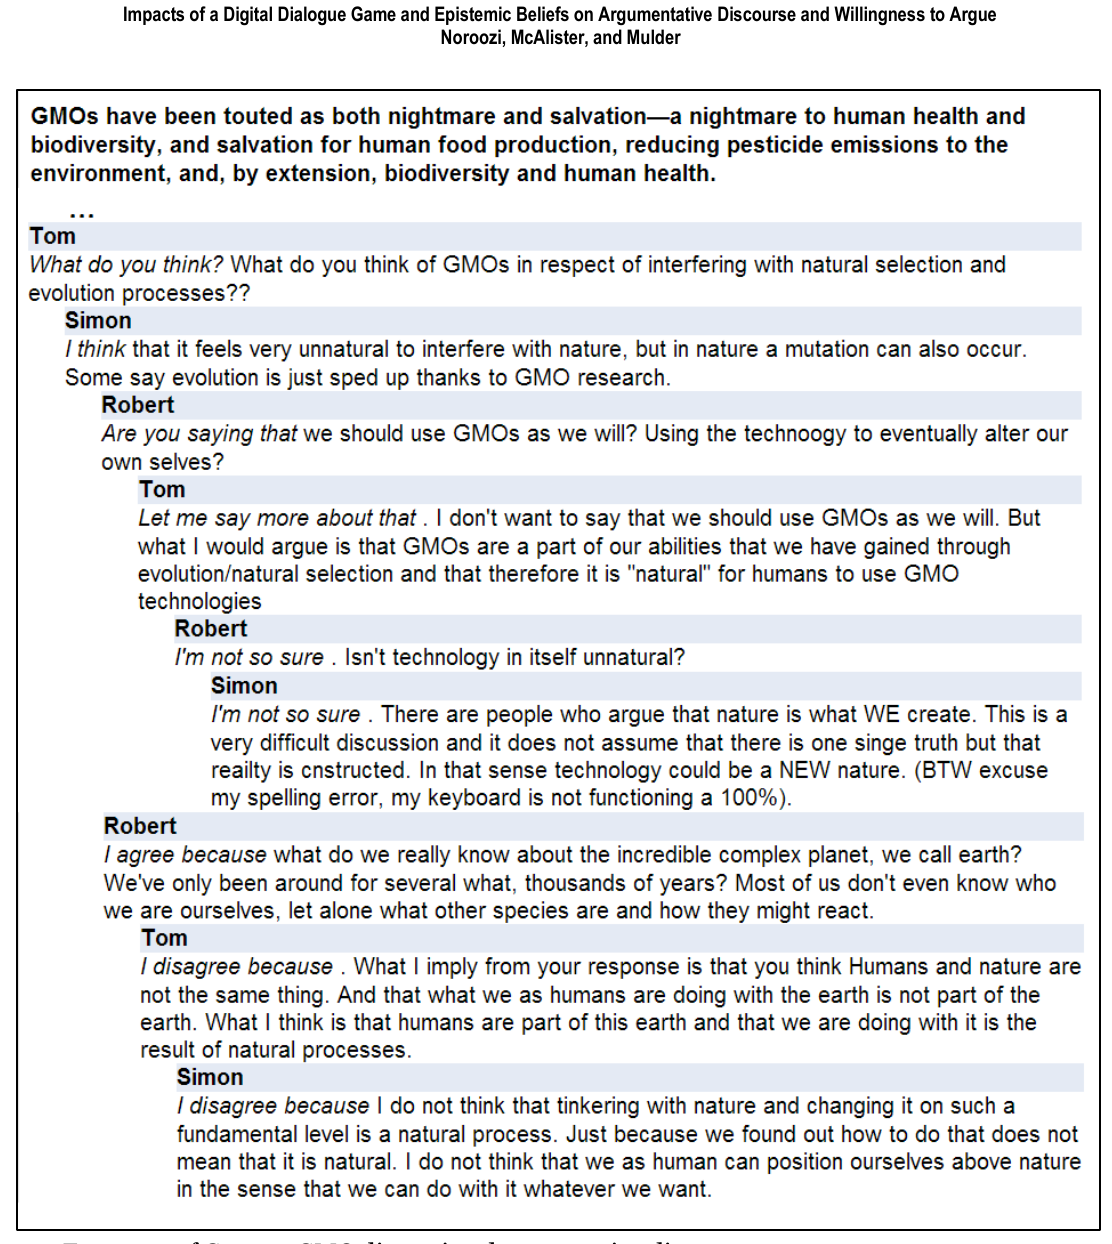
Figure 3. Fragment of Group 1 GMO discussion demonstrating disagreements